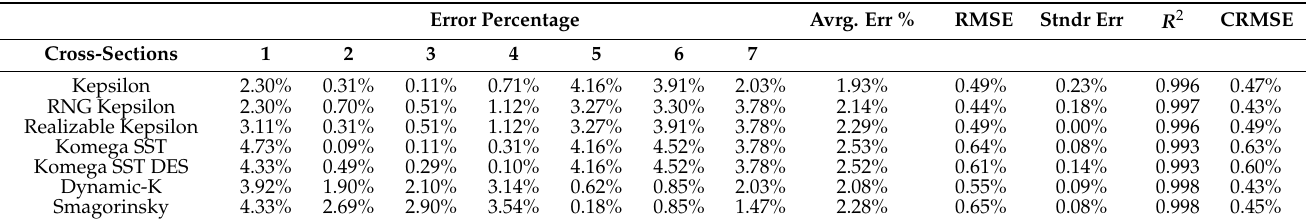
Table 1. The error percentage, root mean square error (RMSE), standard error, R 2 and centered root mean square error (CRMSE) of the simulated data vs. experimental data.